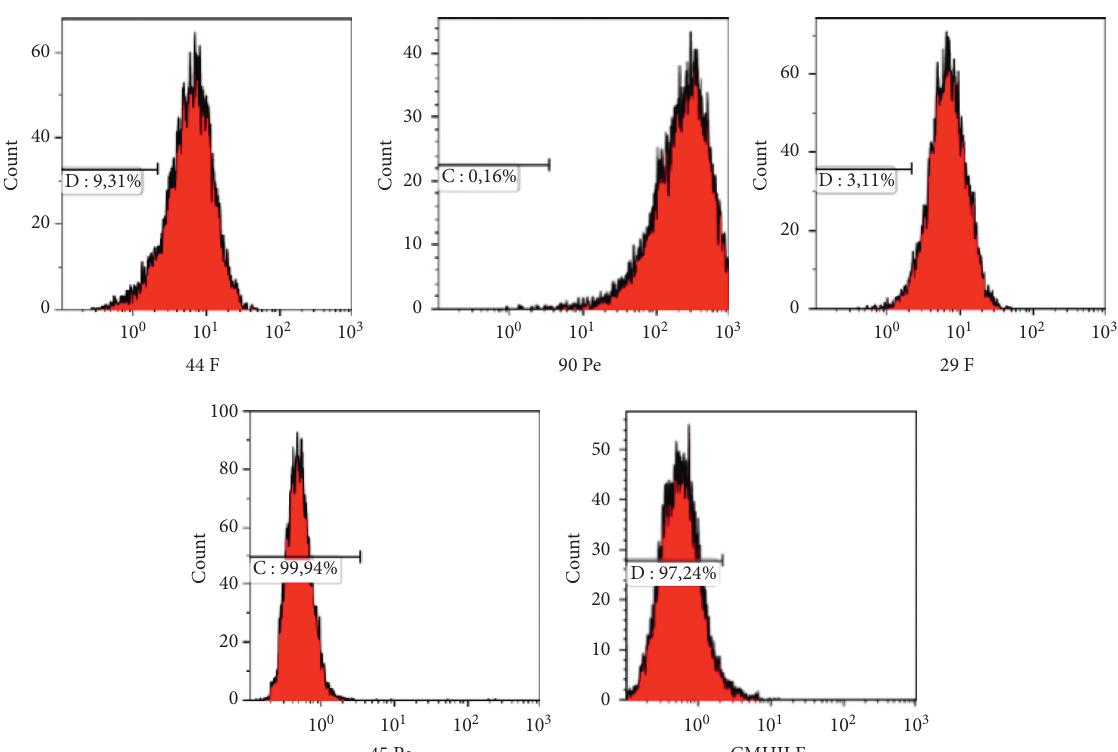
Figure 1: Phenotypic characterization of OM-MSCs. These results show that the cells express a typical MSC phenotypic profile: CD45-/ CD44+/CD90+/CD29+/MHC II.